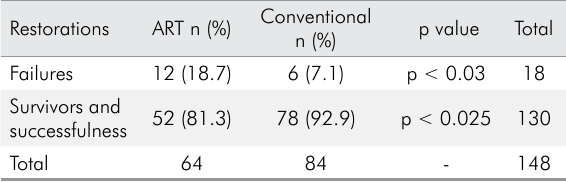
Table 3. Clinical performance of the restorations after six